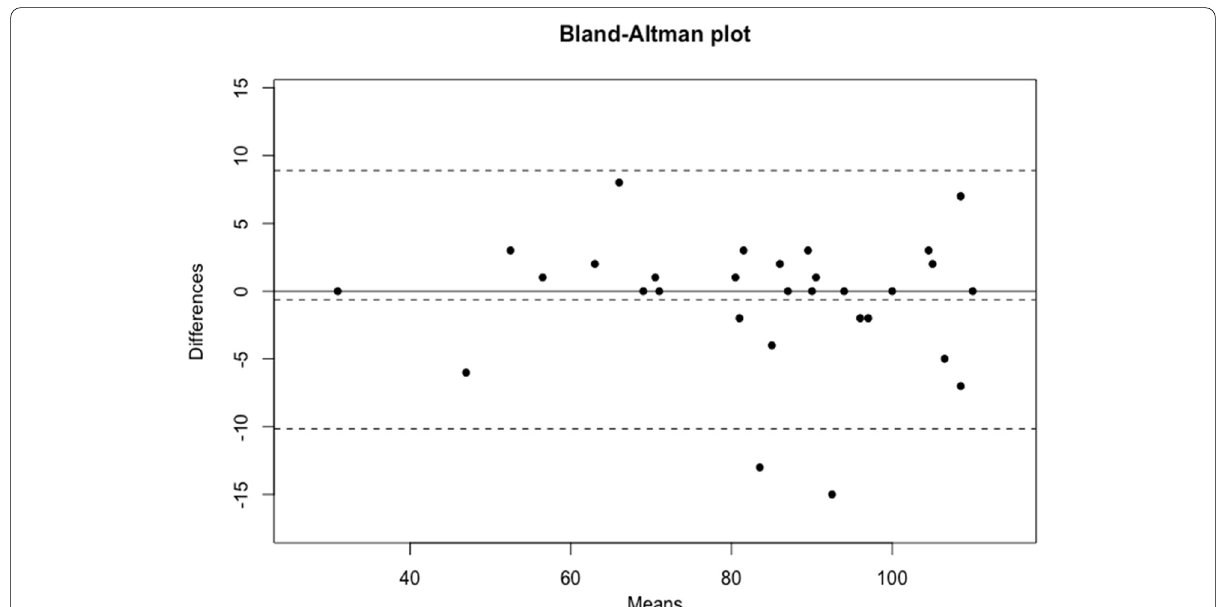
Fig. 1 Reproducibility (test–retest) of the ALR‑RSI‑Fr: Bland and Altman diagram showing good agreement between the two measurements and no systematic